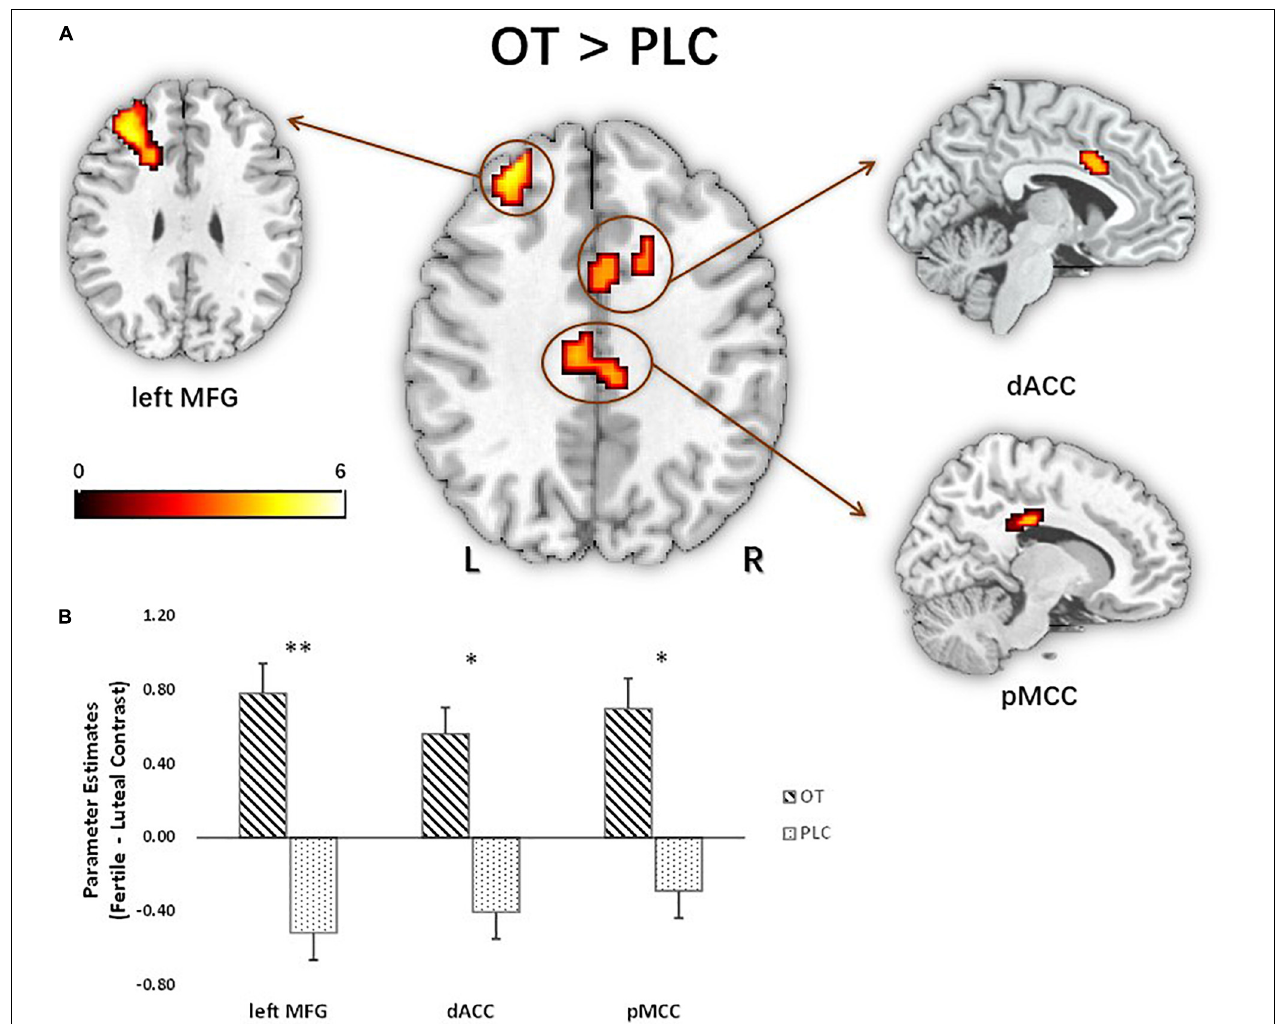
FIGURE 5 | Treatment difference for novel metaphorical compliments based on cycle contrasts (fertile > luteal) in activated brain regions: left MFG, dACC, pMCC ( n = 62). (A) The t map of the post hoc independent t -test effect showed three activated clusters peaking at the left MFG ( x = –30, y = 32, z = 26; t 60 = 5.13), dACC ( x = 9, y = –28, z = 29; t 60 = 4), and pMCC ( x = 24, y = 26, z = 26; t 60 = 4.39). Parameter estimates were extracted using the peak MNI coordinates. (B) Extraction based on the fertile > luteal contrast revealed that oxytocin significantly increased activation in the identified regions relative to placebo, ∗ p < 0.05, ∗∗ p < 0.01, two-tailed t -test. Bars indicate M ± SE. L, left; R, right; MFG, middle frontal gyrus; dACC, dorsal anterior cingulate cortex; pMCC, posterior middle cingulate